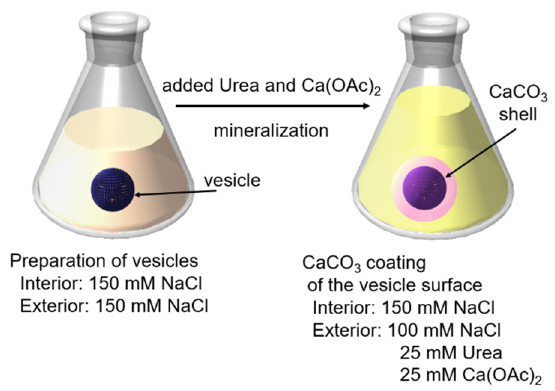
Figure 2. Schematic picture of the fabrication of the CaCO 3 -coated vesicle by the self-supplied min- eralization under the isotonic